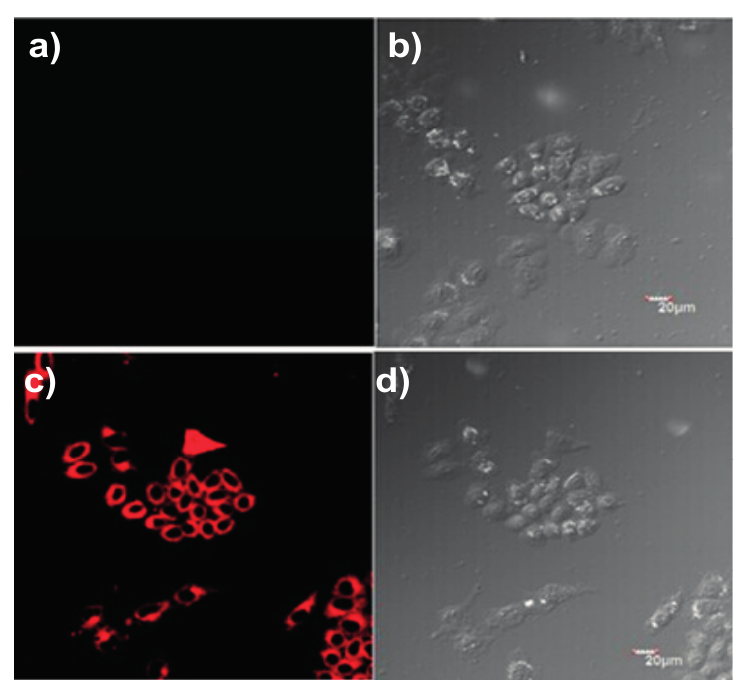
Figure 7. Confocal fluorescence and brightfield images of HepG2 cells. ( a ) Cells stained with 10 μ M P for 30 min at 37 °C; ( b ) bright field image of cells shown in (a); ( c ) cells supplemented with 1 μ M CuCl 2 in the growth media for 30 min at 37 °C and then incubated with 10 μ M P for 30 min at 37 °C; ( d ) brightfield image of cells shown in (c). ( λ ex = 559